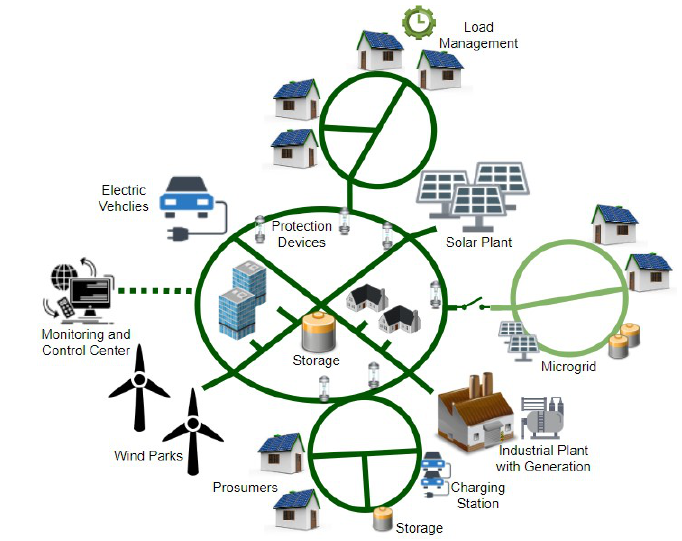
Figure 1. Illustration of an active distribution